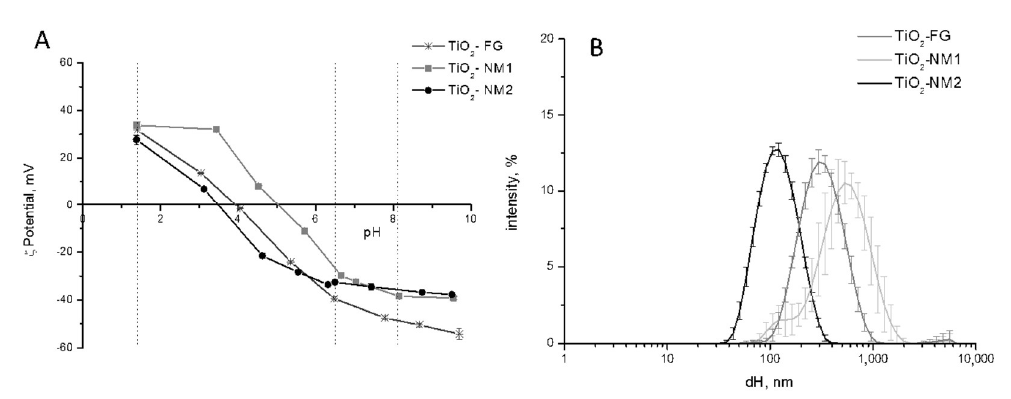
Figure 1. ζ -Potential and size distribution of pristine TiO 2 samples in water. ( A ) ζ -Potential vs. pH, expressed as mean value of three independent measurements ± SD. ( B ) Hydrodynamic diameters (d H ) distribution (% intensity) expressed as mean value of 5 measurements in three independent experiments ± SD.